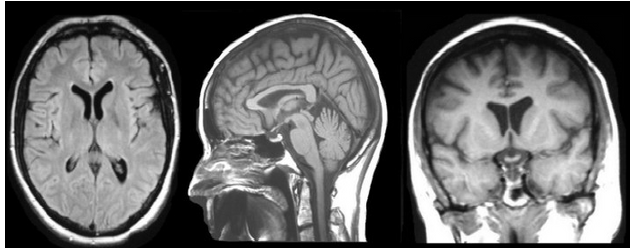
Figure 1. The brain, spinal cord, and vascular anatomy are all thoroughly detailed